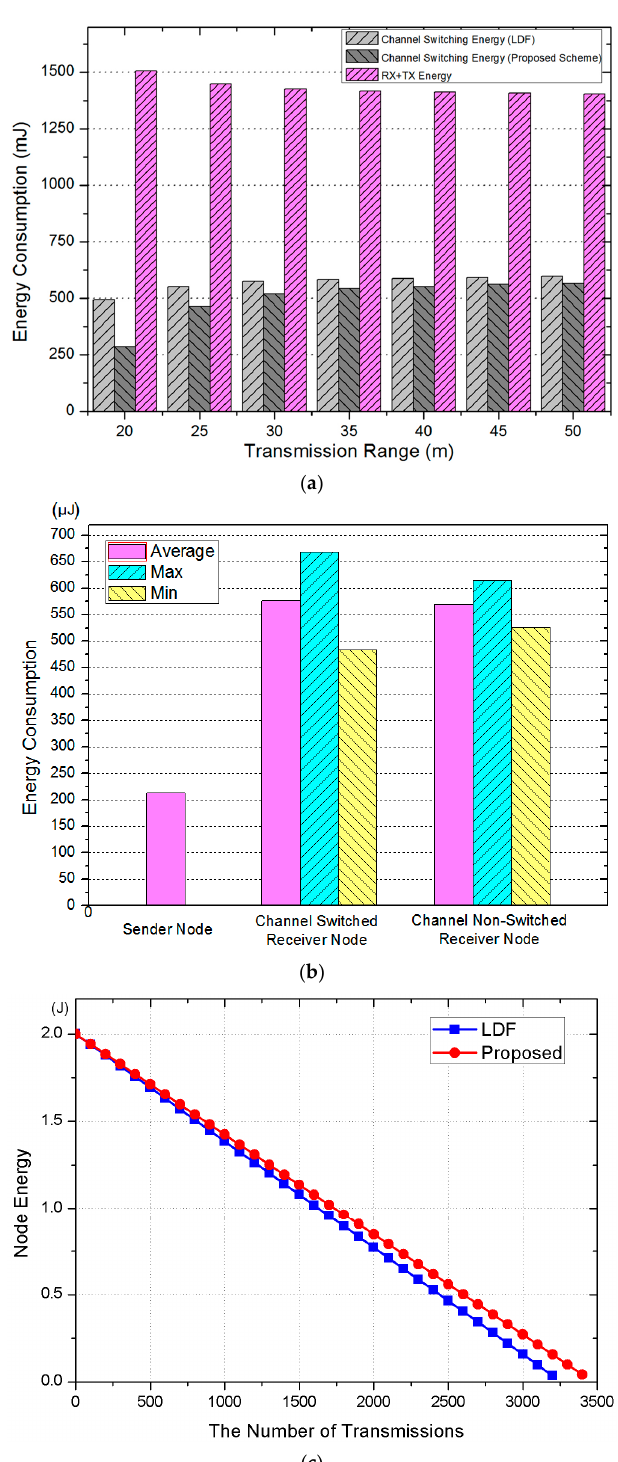
Figure 8. ( a ) Energy consumption simulation results; ( b ) energy consumption by node role; and ( c ) remaining node energy according to the number of transmission.